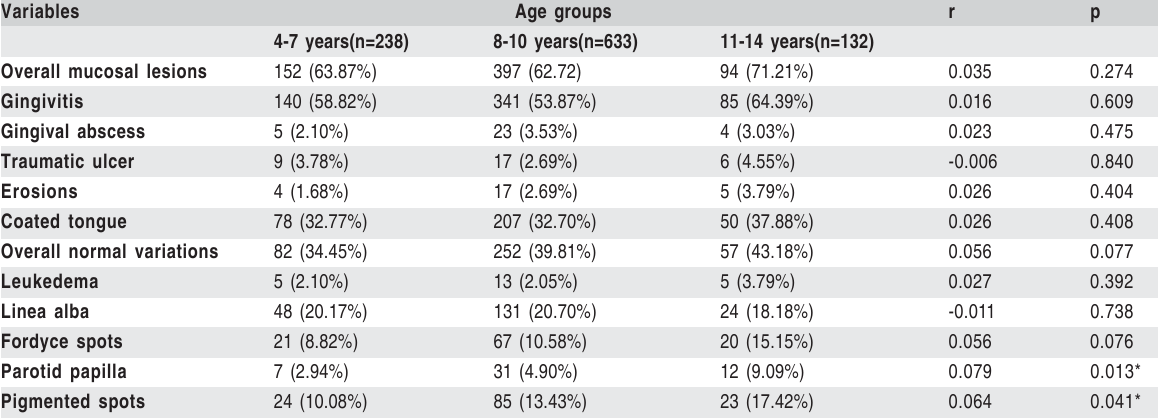
Table 5 - Correlation between mucosal lesions / variations with